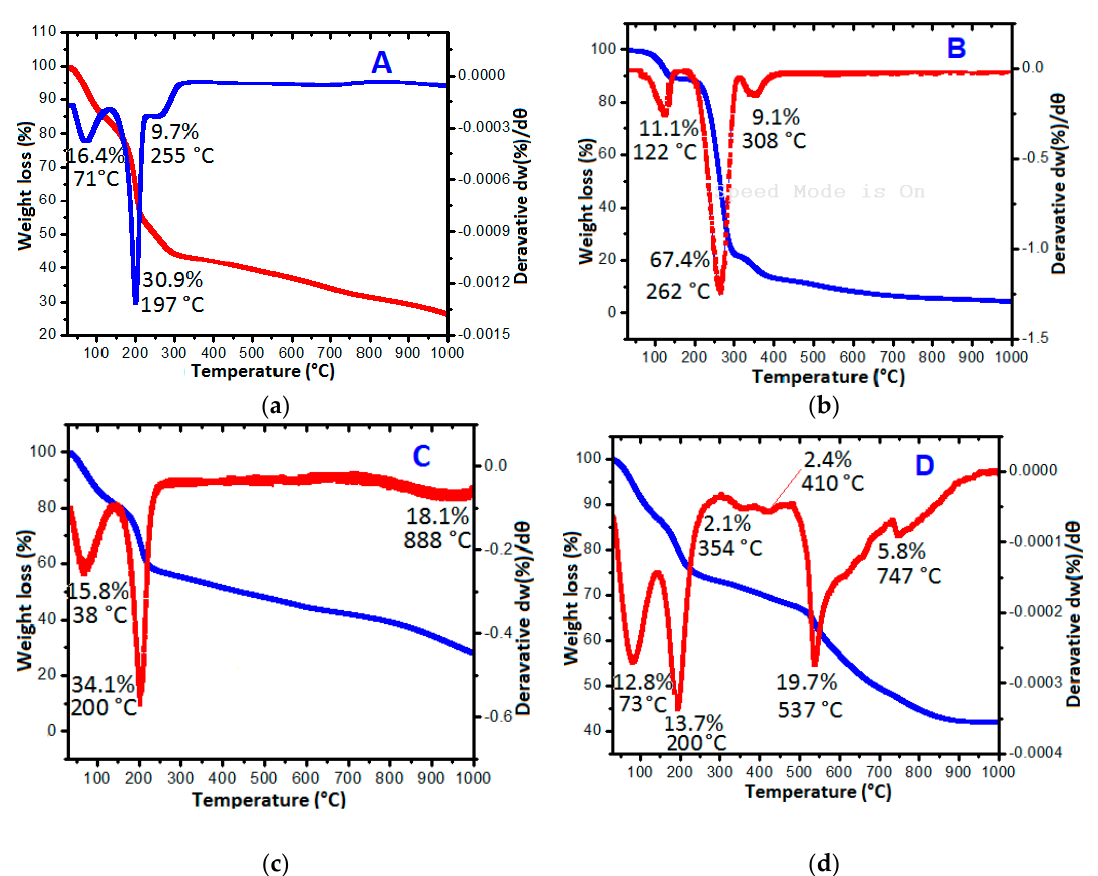
Figure 3. TGA (Blue) and DTG (Red) thermograms of ( a ) GO nanosheets; ( b ) pure protocatechuic acid; ( c ) protocatechuic acid loaded on GO/Gd nanolayers (GAGPA); ( d ) gold nanoparticles coated on GAGPA nanocomposite (GAGPAu).